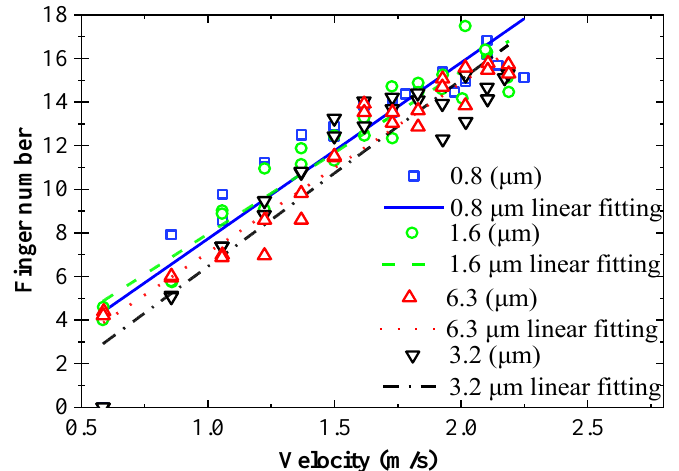
Figure 8. Variation of “finger” numbers with impact velocity.